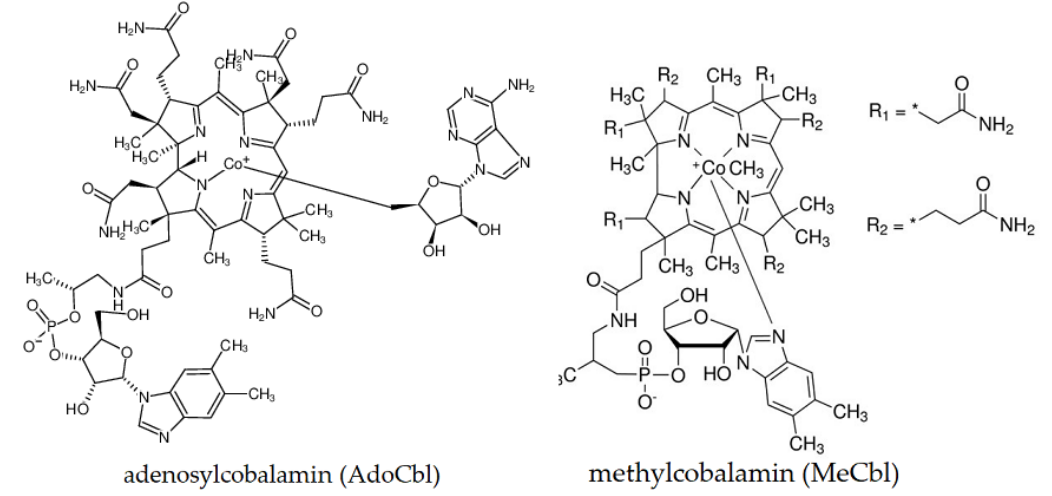
Figure 1. The structural formula of AdoCbl and MeCbl.